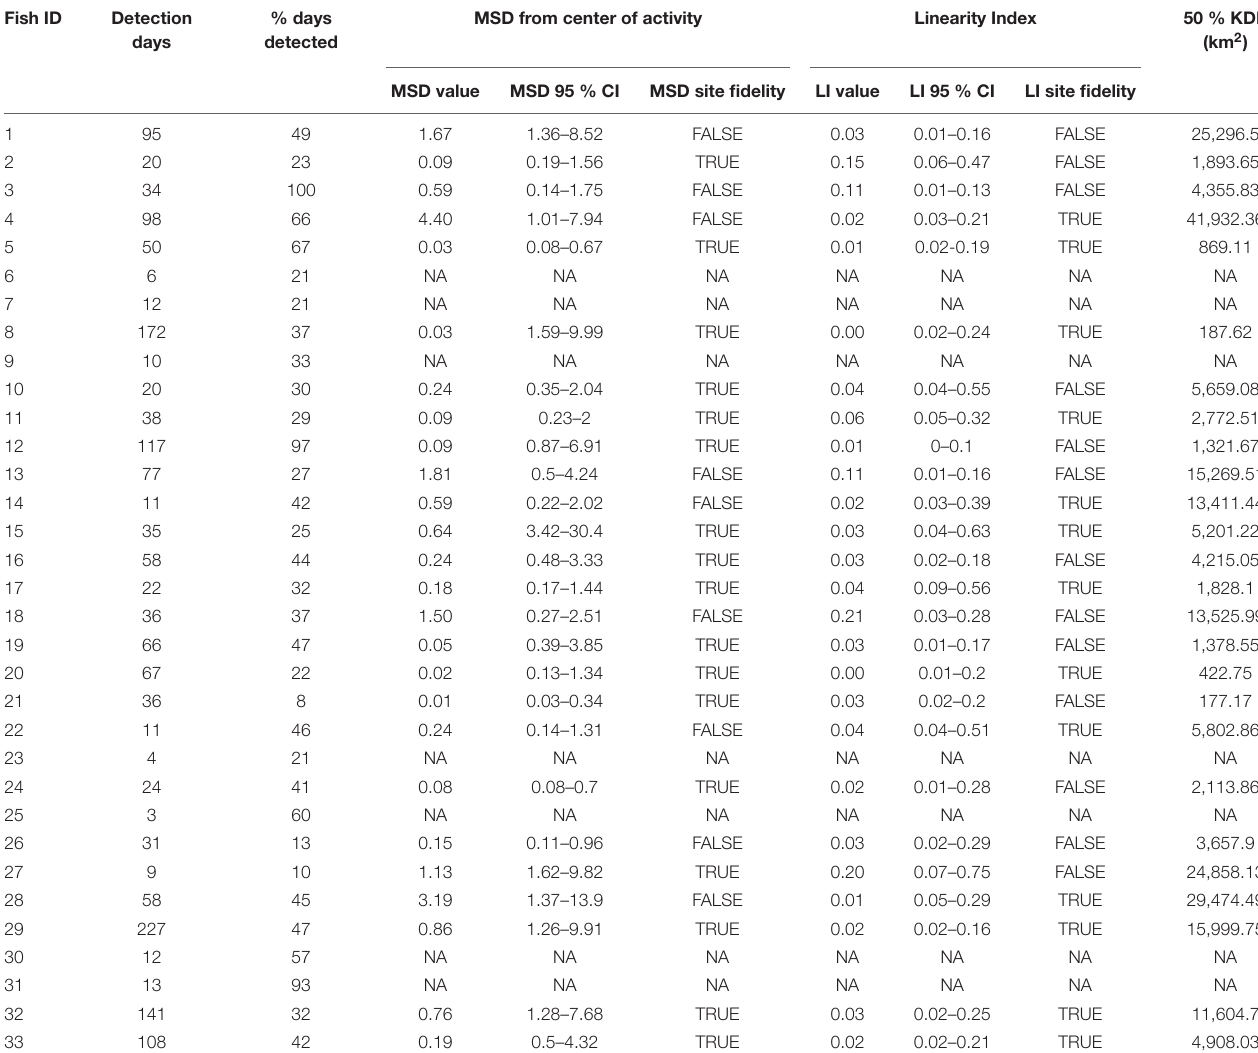
TABLE 2 | Total number of detection days, percent of days at liberty when a daily detection occurred, and summary statistics for site fidelity analysis using mean square distance (MSD) from center of activity and linearity index (LI) of scalloped hammerheads ( n = 26). Fish ID Detection % days MSD from center of days detected